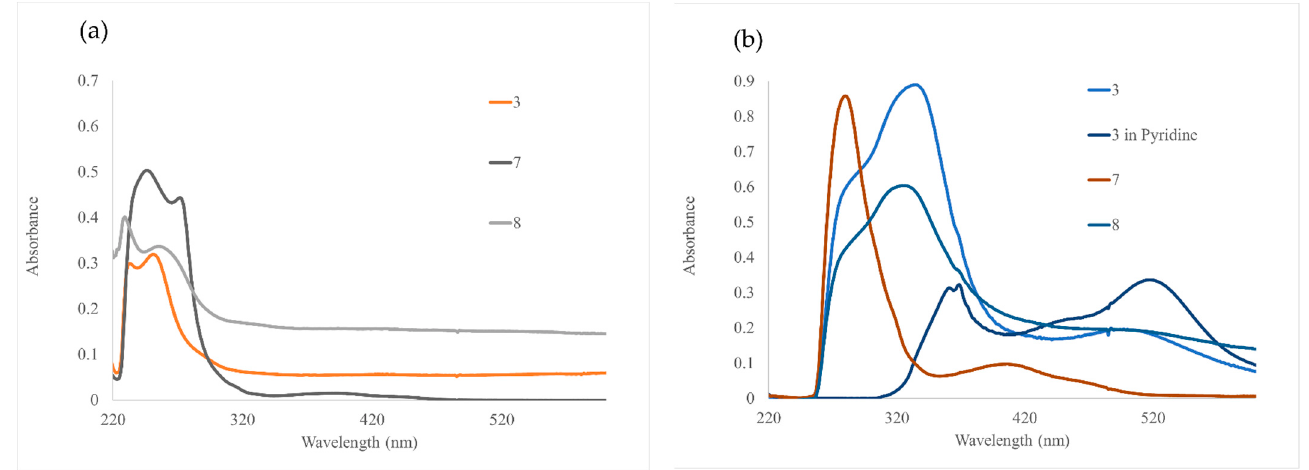
Figure 2. Electronic absorption spectra obtained for 3 , 7 , and 8 in ( a ) DCM and ( b ) DMSO. Complex 3 in pyridine is shown for comparison in ( b ).